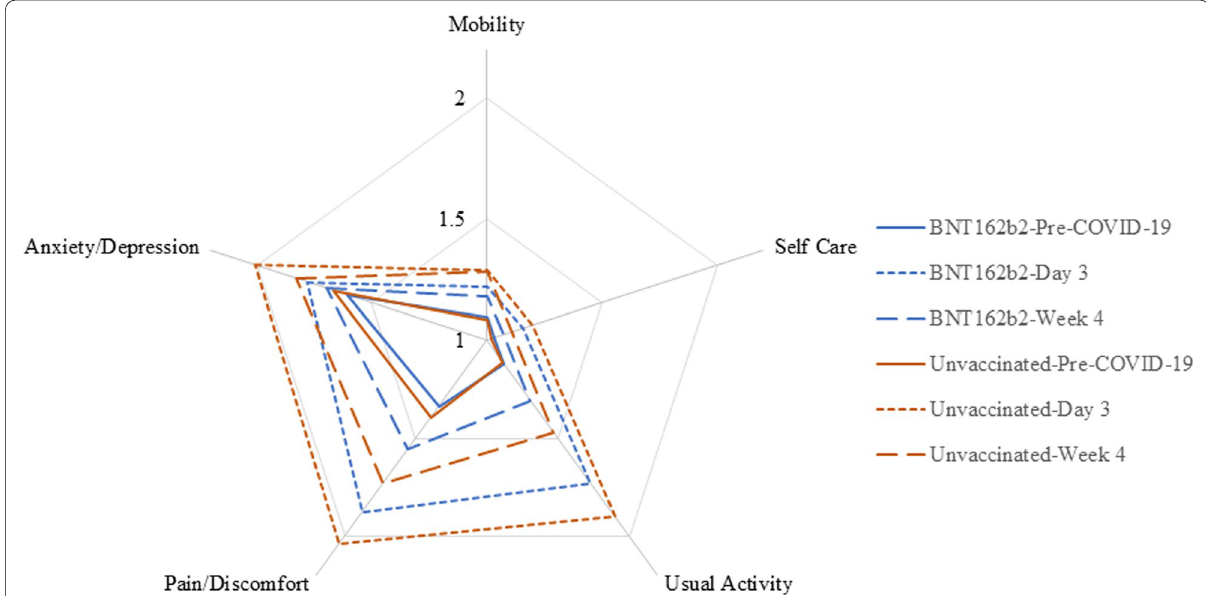
Fig. 3 Mean Responses of EQ-5D-5L Dimensions by Timepoint. Mean dimension scores range from 1 for no problem to 5 for extreme/unable. The blue and red solid lines indicate that vaccinated and unvaccinated were similar at the pre-COVID baseline. At Day 3 and Week 4 post-index date, vaccinated cohort was less impacted (lower scores) than unvaccinated by COVID on anxiety/depression, pain/discomfort, and usual activities (dotted lines for Day 3, dashed lines for Week